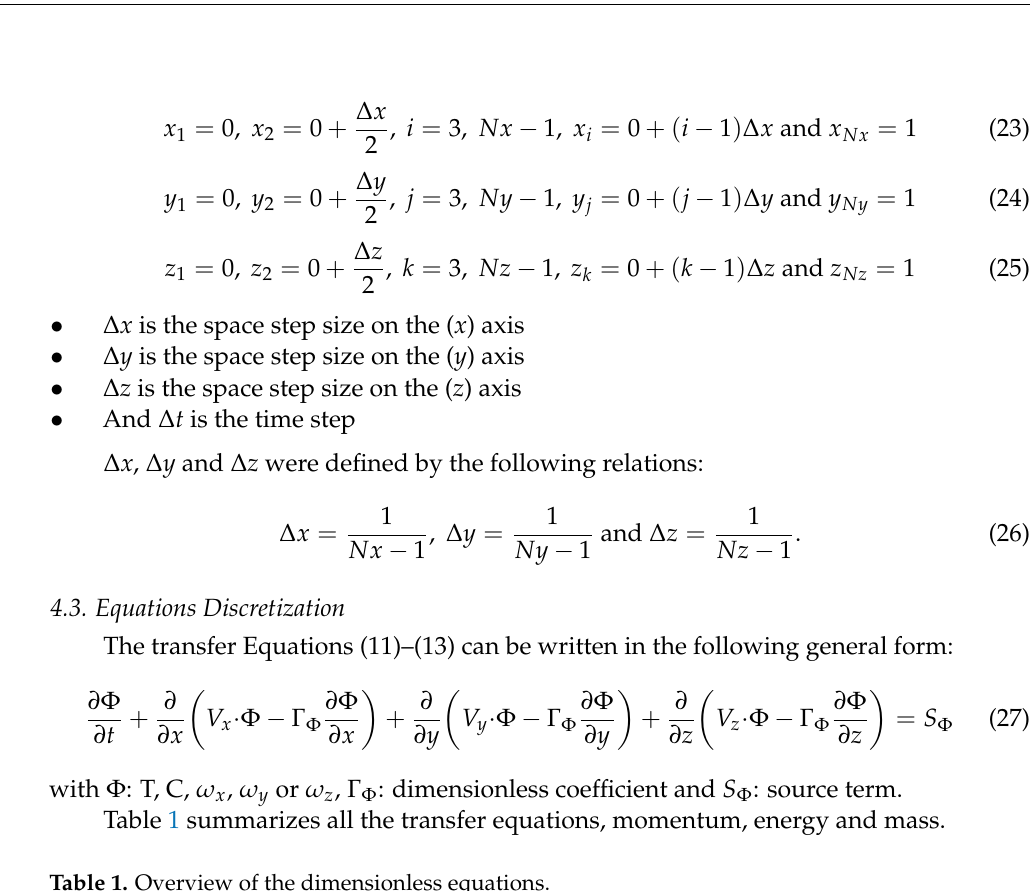
Table 1. Overview of the dimensionless